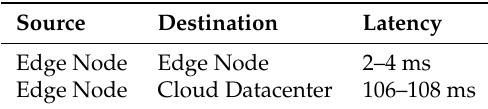
Table 3. Network